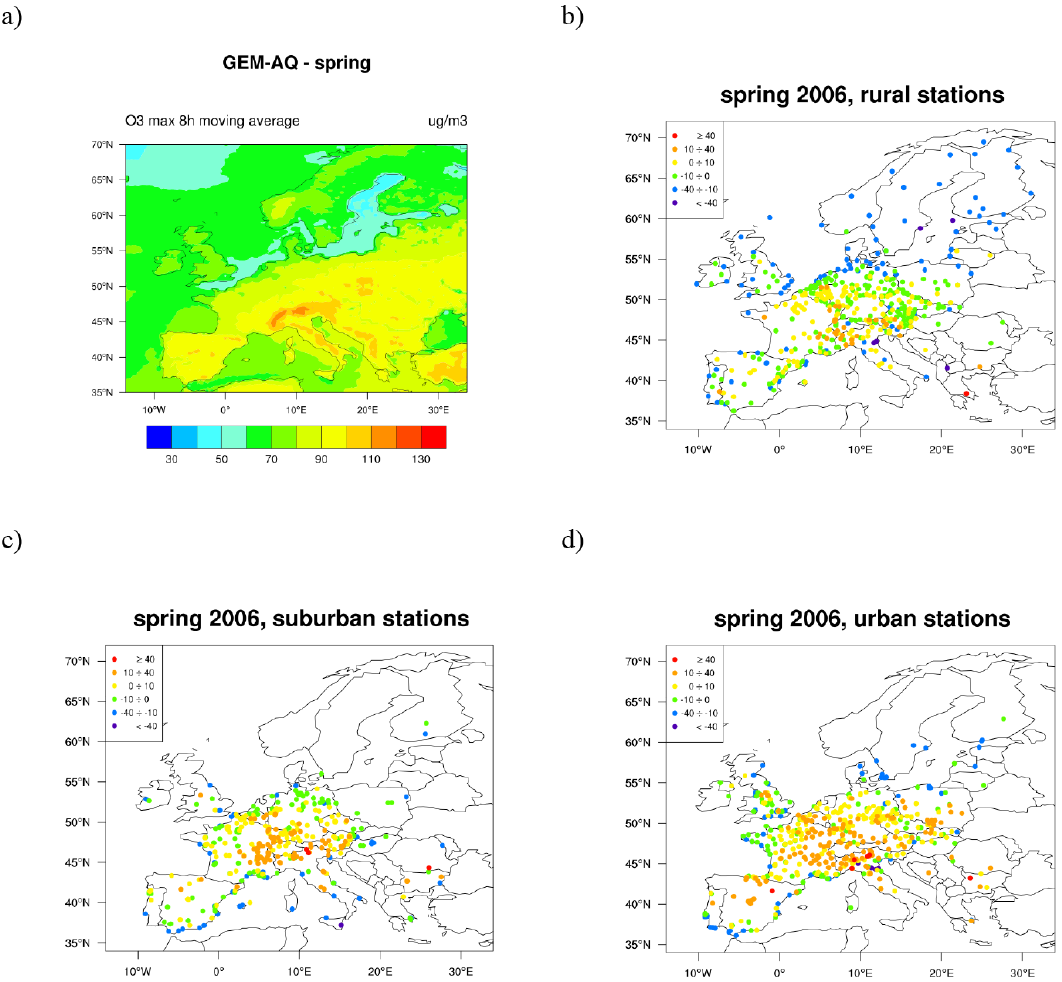
Figure 4. Spring (MAM) maximum 8h running average ozone concentration in µgm − 3 (a) , MBE at rural stations (b) , MBE at suburban stations (c) and MBE at urban stations (d)